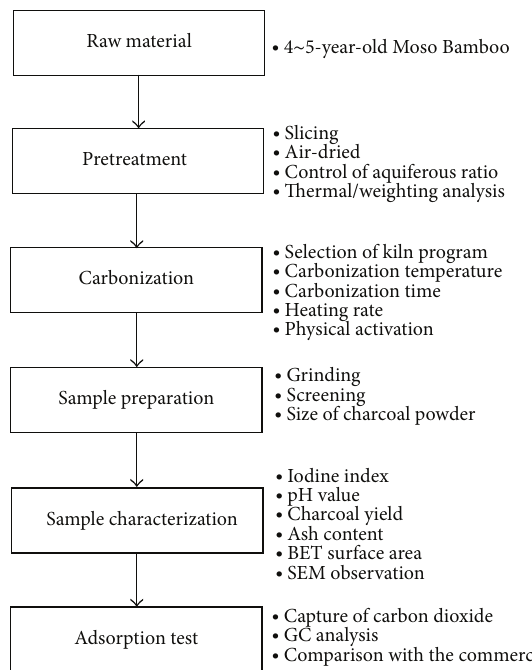
Figure 1: Procedure for preparing the Moso-bamboo-based porous